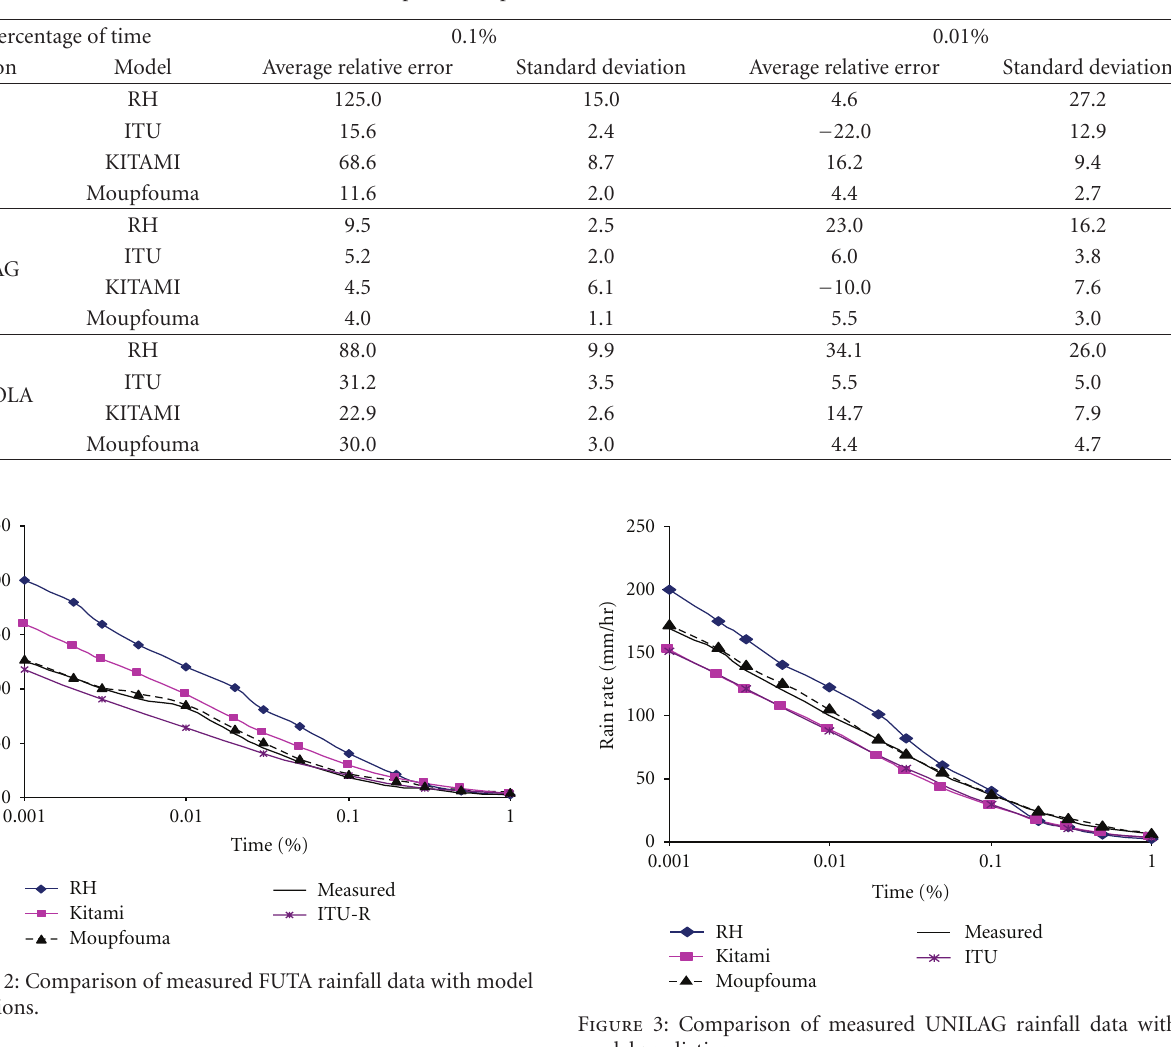
Table 2: The composite comparison statistics for the di ff erent models.